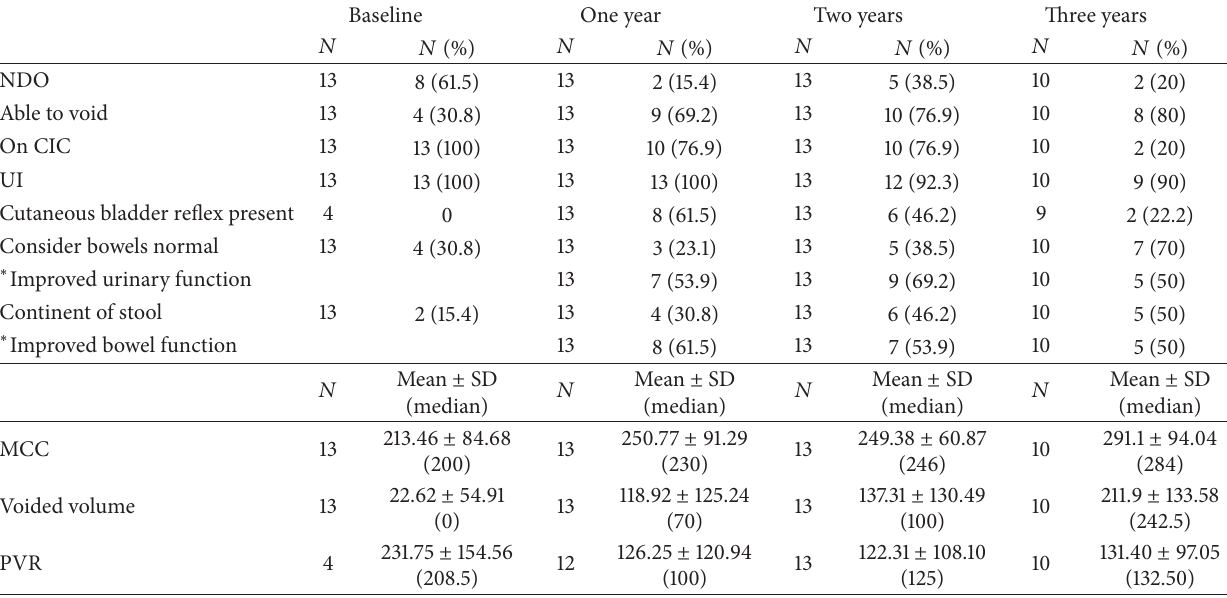
Table 1: Summary of changes over